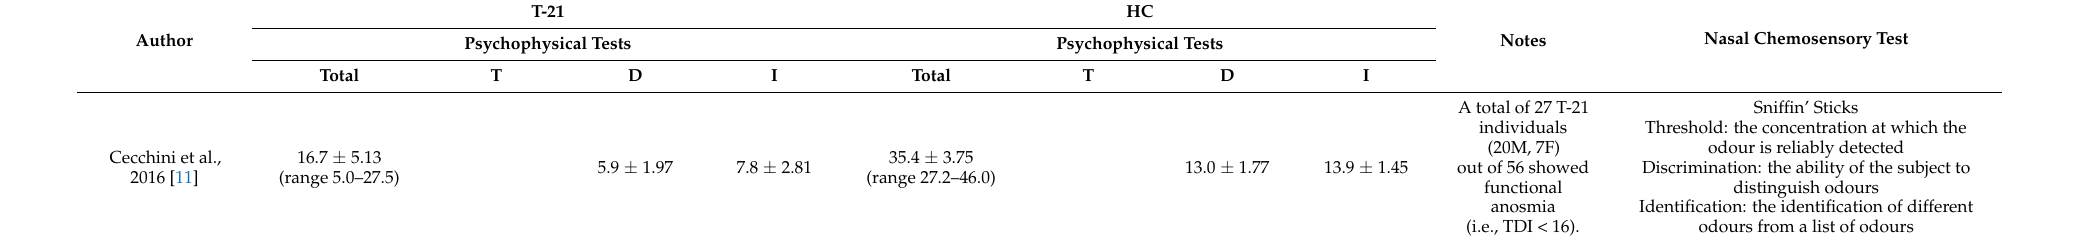
Table 2. Psychophysical result of the individual with trisomy 21 and healthy control